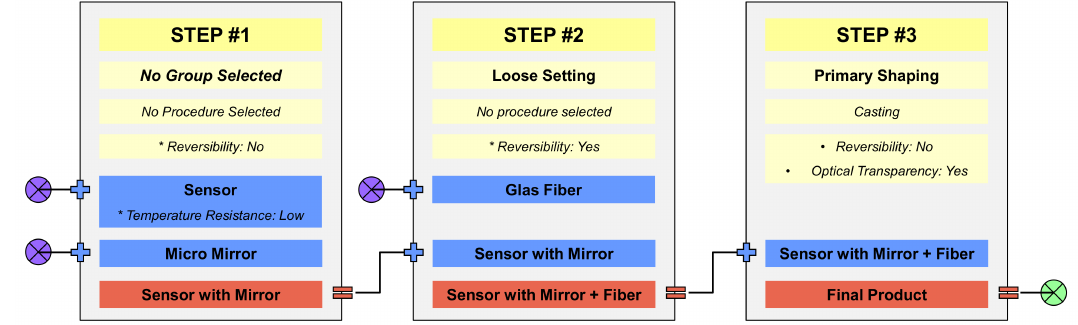
Figure 3. Schematic example of an assembly sequence model with three assembly steps. Procedure group, procedure type, and process properties are presented in the light yellow boxes. Blue boxes are used for input components and their properties, red ones for output components and their properties. Purple circles are sources, green circles wells. In the first step, a micro mirror is assembled to a sensor with low temperature resistance. This happens without further restrictions regarding the procedure group and type. The assembly should not be reversible. The created sensor with mirror is used as an input component in the second step. There, it is joined with a glass fiber to a sensor with mirror + fiber. This assembly step must use the group “loose setting” and be reversible. The last step must not be reversible, but optically transparent. The sensor with mirror + fiber is encapsulated, so the procedure group is “primary shaping”, while the procedure type is